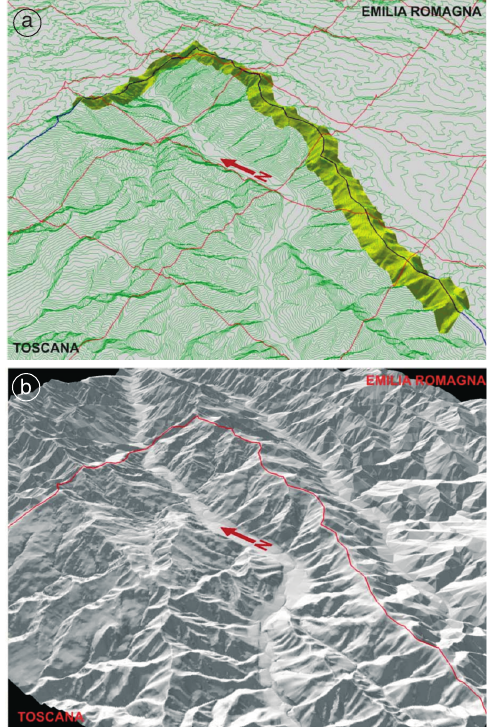
Fig. 5a,b. a) Perspective view of two contiguous ar- eas with different spatial resolutions: in the bottom left portion the Toscana Region with denser contour lines and, in the upper portion, the Emilia Romagna Region with lower resolution data. In the yellow belt merging between the two areas is forced. Red lines represent tile edges, the tiles in foreground are 2.5 × 2.5 km 2 . The thin solid blue line is the administrative boundary between the two Regions. b) The same view of (a) showing the obtained